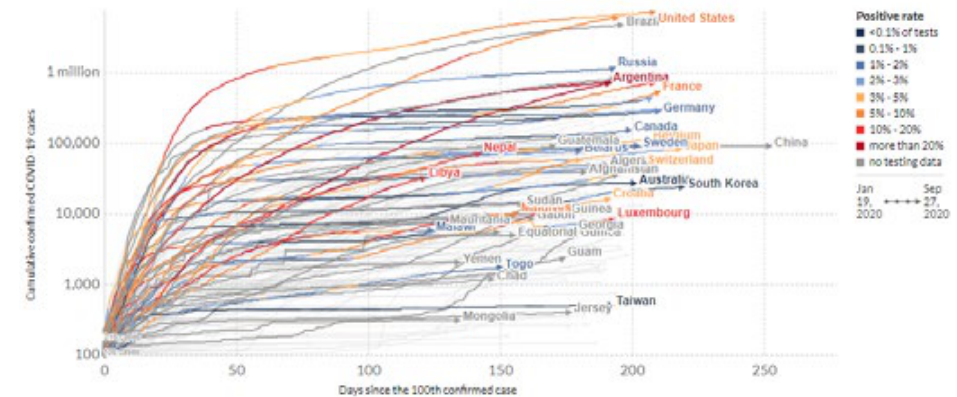
Fig. 2: Confirmed COVID-19 cases in total (CDCP,